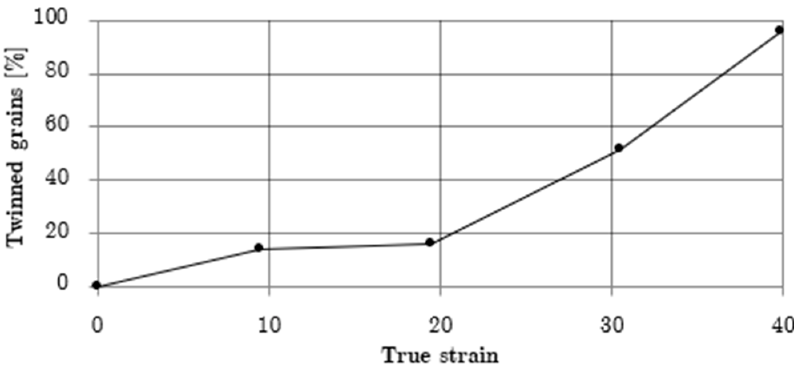
Figure 17. Percentage of twinned grains for different deformation